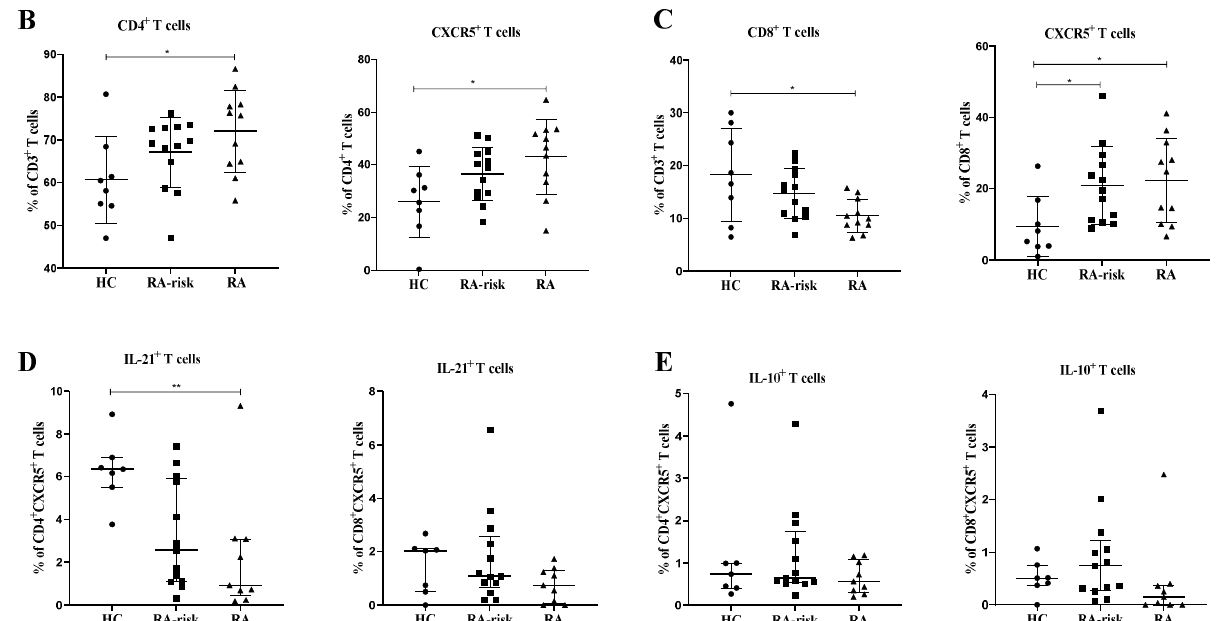
Figure 2. Analysis of follicular helper T cells in lymph node biopsies. ( A ) Gating strategy for follicular-like T cells in lymph node biopsies using markers for CD3, CD4, CD8, CXCR5, IL21, and IL-10. For gating of CD4 + cells after stimulation, the largest CD3 + CD8 - population was considered to be CD4 + cells, as our unstimulated cells indicated that this corresponds to CD4 + cells. This approach was used because the downregulation of CD4 was observed in lymph nodes upon PMA/ionomycin stimulation. ( B , C ) Frequencies of CD4 + , CD4 + CXCR5 + , CD8 + , and CD8 + CXCR5 + T cells in lymph nodes are shown for healthy controls (HC, n = 8), RA-risk individuals (RA-risk, n = 13), and early RA patients (RA, n = 11). ( D , E ) The frequencies of IL-21 + and IL-10 + cells within the CD4 + CXCR5 + and CD8 + CXCR5 + populations are plotted for healthy controls (HC, n = 7), RA-risk individuals (RA-risk, n = 13), and early RA patients (RA, n = 9). Non-normally distributed data are presented as median with IQR, and normally distributed data are presented as mean with SD. For statistical analysis, Kruskal–Wallis or one-way ANOVA (when appropriate) was performed, and significant differences are indicated as * p < 0.05 or ** p < 0.01. Non-parametric analysis was conducted on study groups with n < 8. Shapiro–Wilk test was conducted to further confirm normality in this group. All symbols represent data from single individuals ( healthy controls (HC); ■ RA-risk individuals (RA at-risk); ▲ early RA patients (RA)).